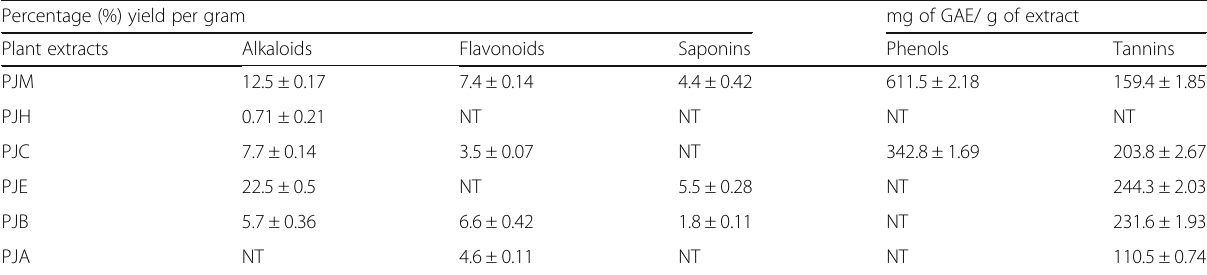
Table 3 Quantitative phytochemical analysis of P. jacquemontiana leaves methanol extract and its derived fractions Percentage (%) yield per gram